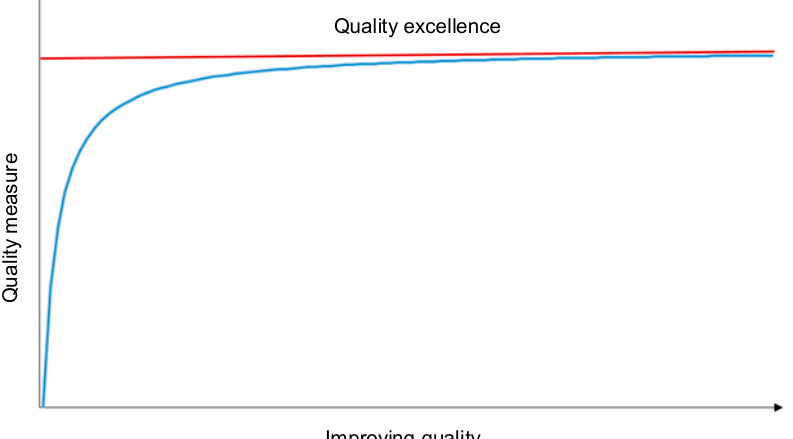
Figure 16. Illustration of the process of improving quality as a pursuit of excellence [40].